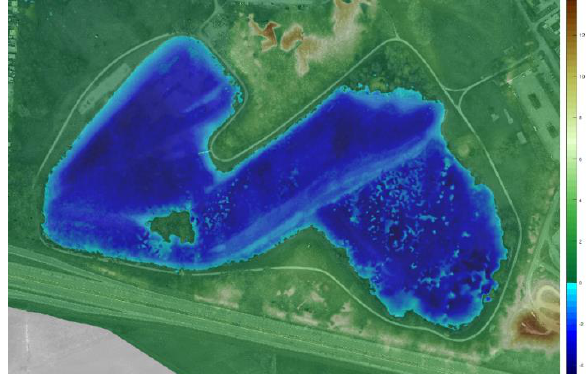
Figure 5. Interpolated DEM from image data with orthophoto mosaic in the background layer. The point heights are given relatively to water level in